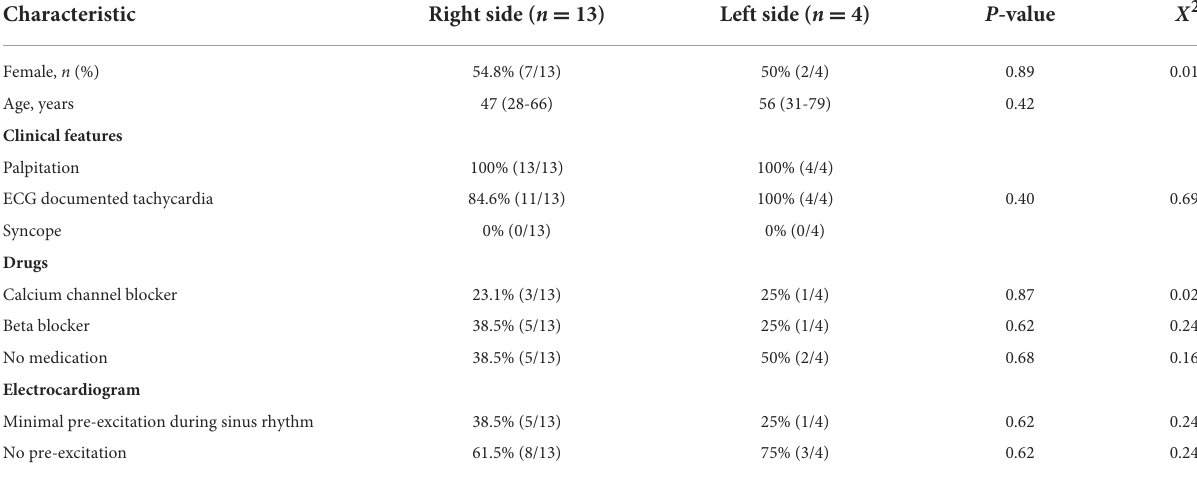
TABLE 1 Clinical characteristics of patients with MAPs.